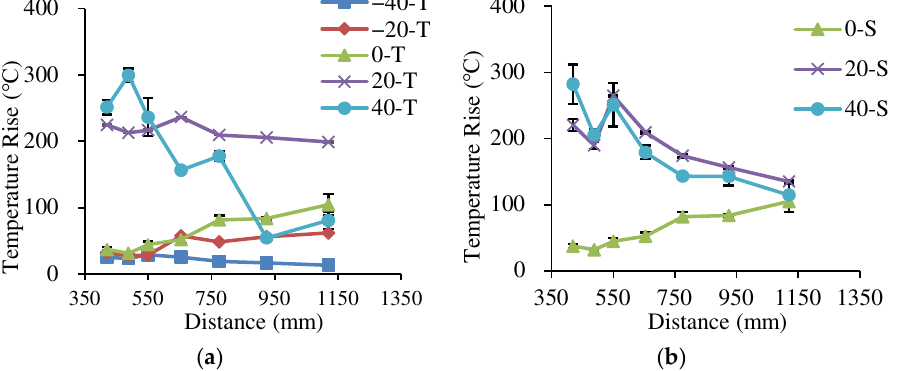
Figure 11. The temperature rise of ( a ) the vertical and ( b ) horizon axis in the exhaust pipe under the fuel flow rate of 10.0 mL/min with the air flow velocity of 2.0 m/s.